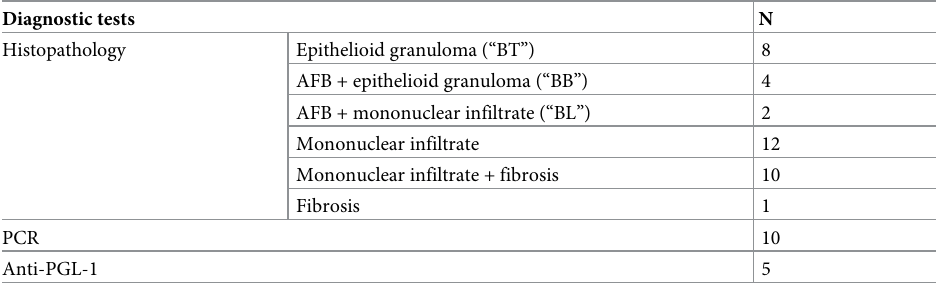
Table 2. Diagnostic tests carried out for the sample of patients.